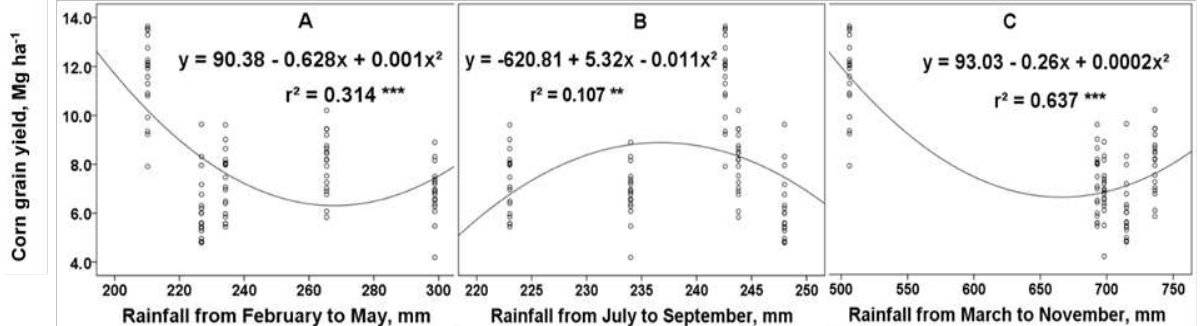
Figure 2. Relationships between corn yield and the rainfall for the specific periods (( A ), February to May; ( B ), July to September; ( C ), March to November) during the seasons over 10-years (2004–2013) under corn-soybean rotation in a clay loam soil, Woodslee, ON, Canada. ** and ***, significant at p ≤ 0.01 and 0.001, respectively.